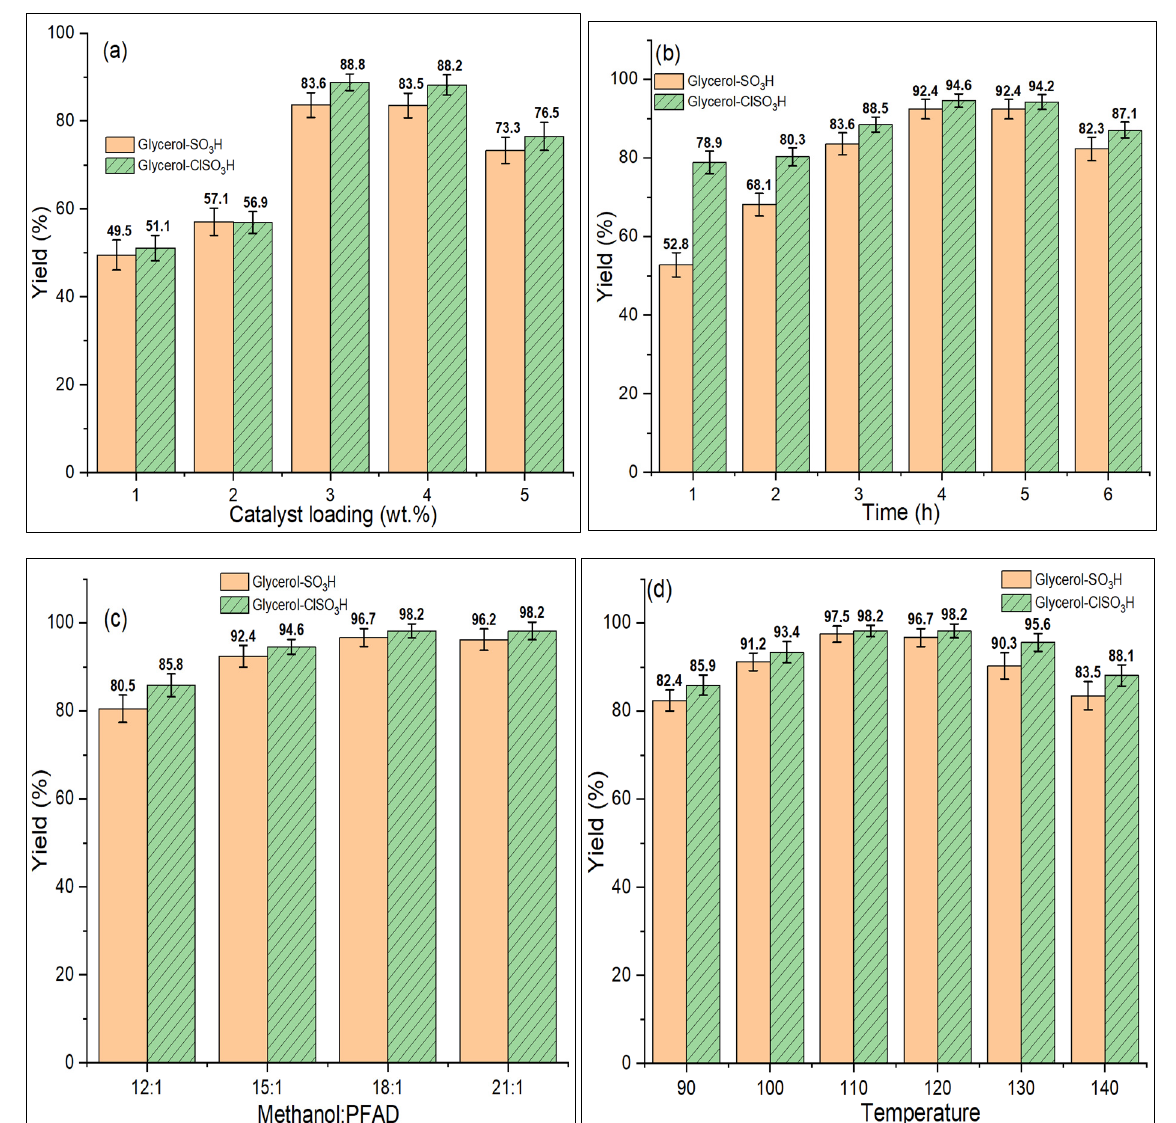
Figure 7. Catalytic performance optimization test ( a ) catalyst loading, ( b ) reaction time, ( c ) methanol-oil molar ratio and ( d ) reaction temperature.